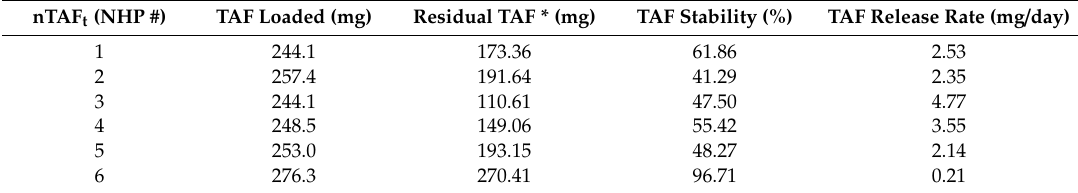
Table 1. nTAF t drug residual after 1 month